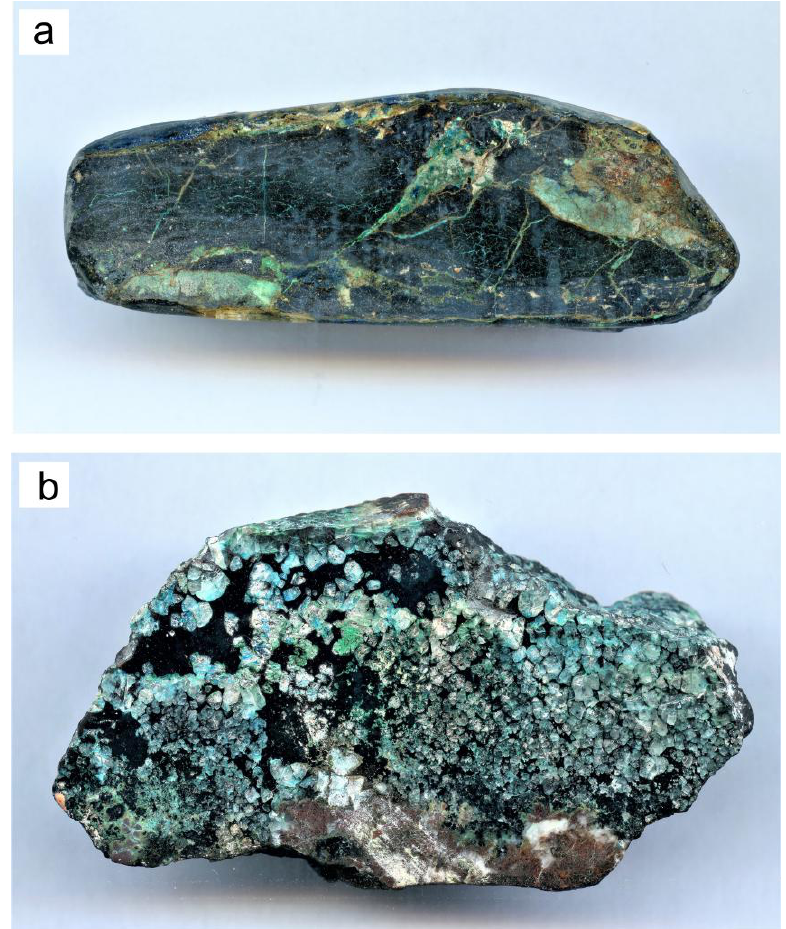
Figure 19. ( a ) Dispersed-light dark field image of Se-veinlet Type-4 from Sierra de Cacheuta (2.2-cm-thick, 6.6-cm-wide, embedded in resin, polished surface). The opaque metallic selenides appear black. Vein selvage, host-rock fragments and diagonal fractures are stained by various alteration products like goethite (dark brown), azurite and chalcomenite (blue), and malachite (green). ( b ) Dispersed-light dark field image of a representative Se-veinlet sample from the La Millionara Mine, Sierra de Cacho District, Province of La Rioja (3.8-cm-thick, 7.1-cm-wide, polished surface). The undeformed Se mineralization (black) consists of umangite, berzelianite and klockmannite. The selenides cement the euhedral crystals (average grain size 2 mm) and crystal aggregates of calcite (white), which are intensively stained by chalcomenite (blue) and malachite (green). Collection F.N. Keutsch, Harvard University, Cambridge, MA, USA.